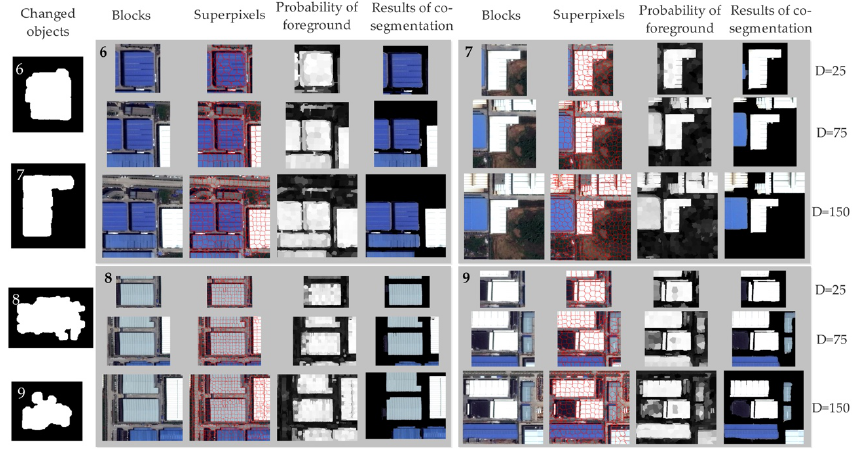
Figure 9. Co-segmentation results with different D values.